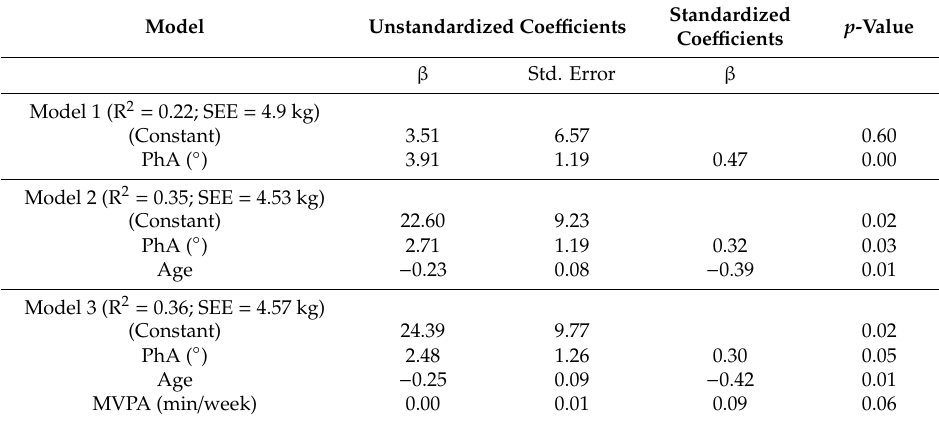
Table 2. Unadjusted and adjusted models using phase angle (PhA) as the independent variable for determining maximal isometric forearm strength.